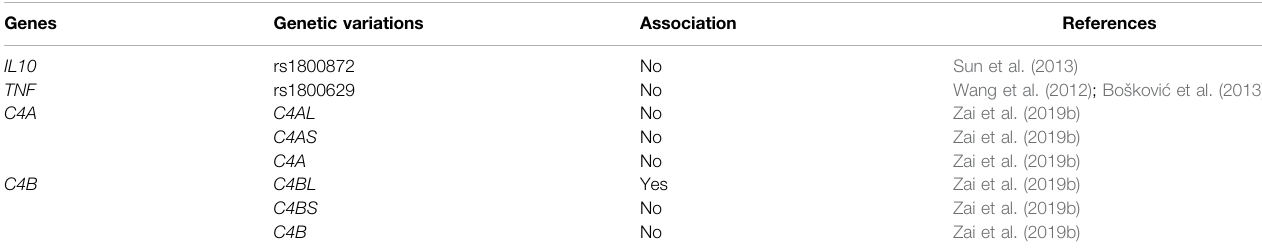
TABLE 9 | In fl ammation: genetic variations and associations with TD. Genes Genetic